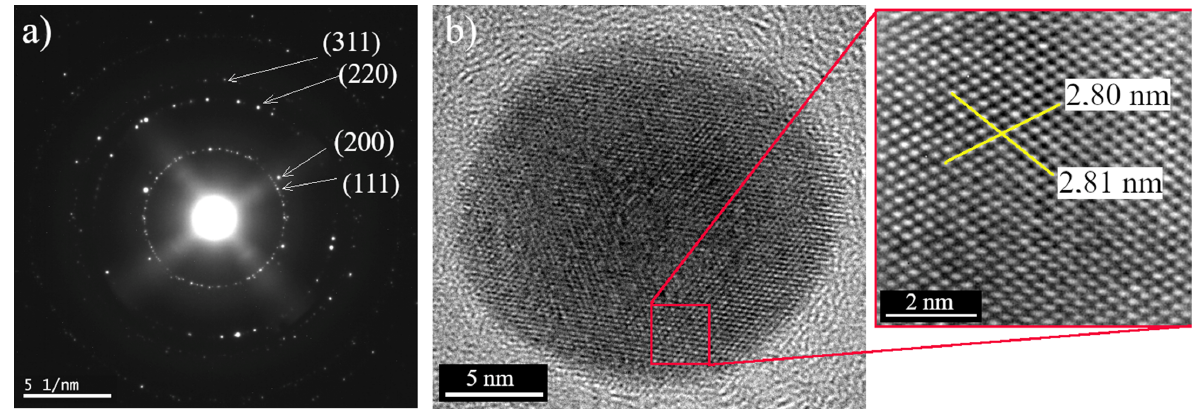
Figure 5. The electron diffraction of AgNPs ( a ); AgNPs structural lattice and lattice fringes of the synthesized AgNPs ( b ). synthesized AgNPs ( b